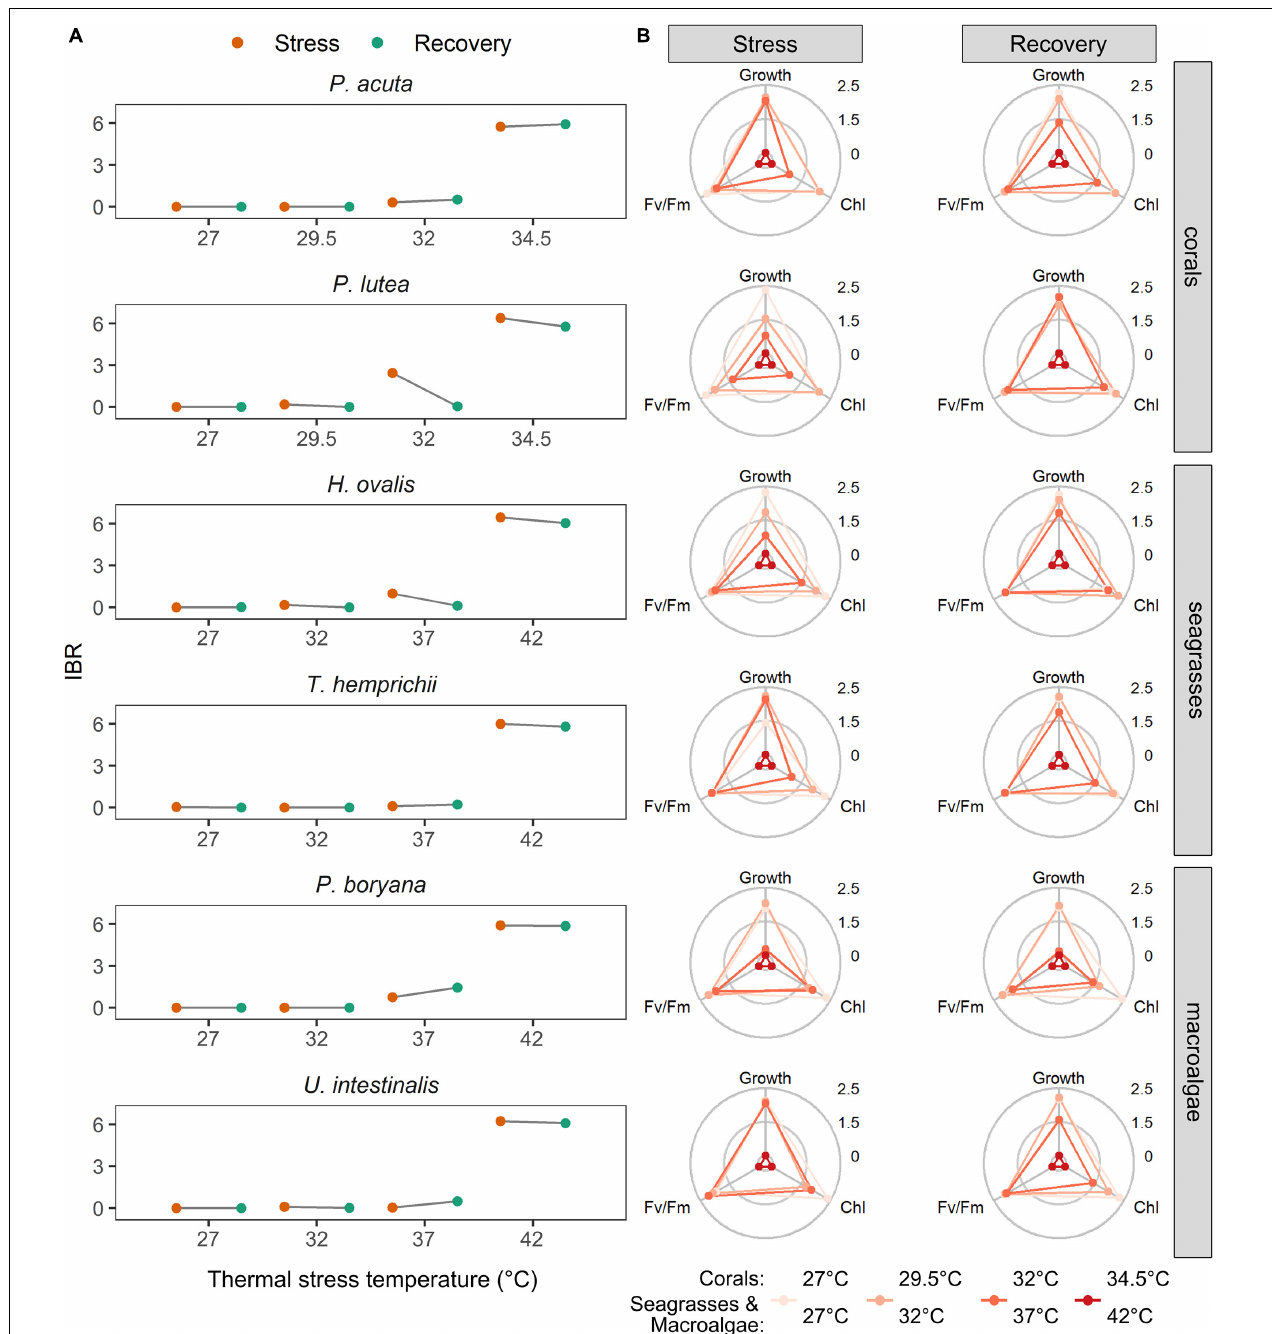
FIGURE 6 | (A) The effects of experimental temperatures on the integrated biomarker response (IBR) indices calculated from F v / F m , chlorophyll contents and growth rates of corals, seagrasses and macroalgae. (B) Star plots with mean scores for F v / F m , chlorophyll contents and growth rates in all tested species. Chl – total chlorophyll content. Growth – growth rates measured as an increase in biomass. Corals were subjected to 27–34.5 ◦ C in stress period and 27 ◦ C in recovery period. Seagrasses and macroalgae were subjected to 27–42 ◦ C in stress period and 32 ◦ C in recovery